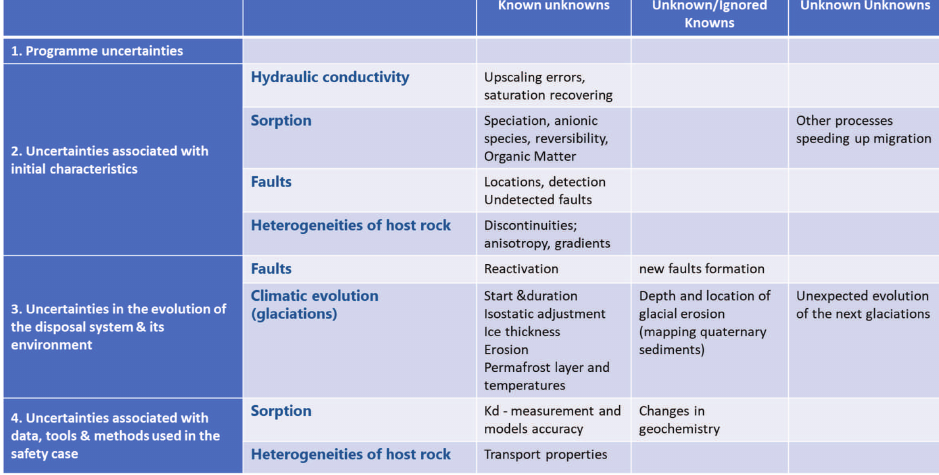
Fig. 8. Uncertainty matrix filled in for safety-relevant site and geosphere